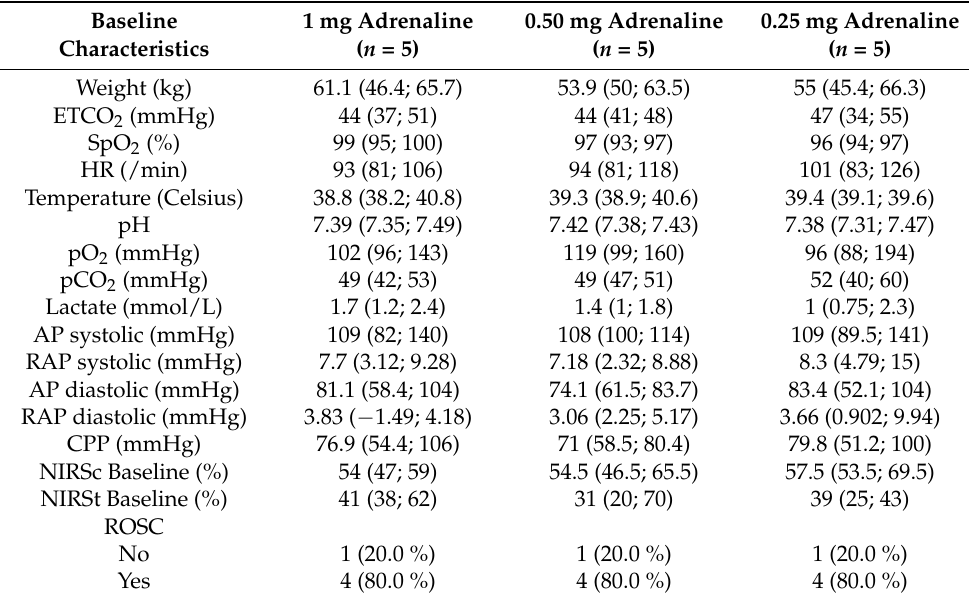
Table 1. Baseline characteristics of specimen according to randomization